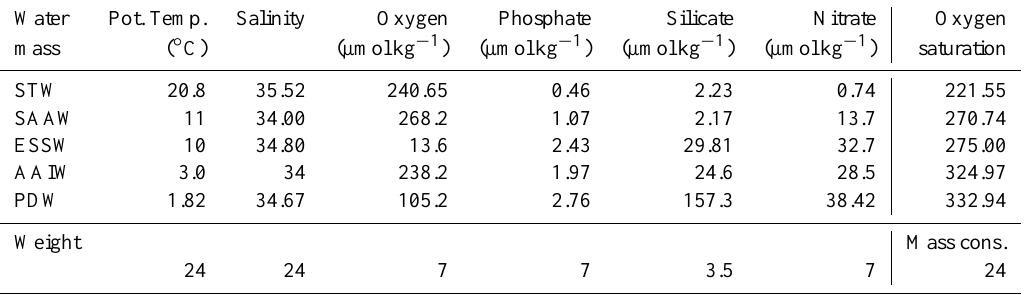
Table 1. Source water types used for the extended OMP analysis. The source water masses are subtropical water (STW), subantarctic water (SAAW), equatorial subsurface water (ESSW), antarctic intermediate water (AAIW) and pacific deep water (PDW). The weights used for each parameter are included in the bottom row. The oxygen saturation concentrations based on the source water types of temperature and salinity are given in the last column (based on Garcia and Gordon, 1992). Water Pot. Temp. Salinity Oxygen Phosphate Silicate